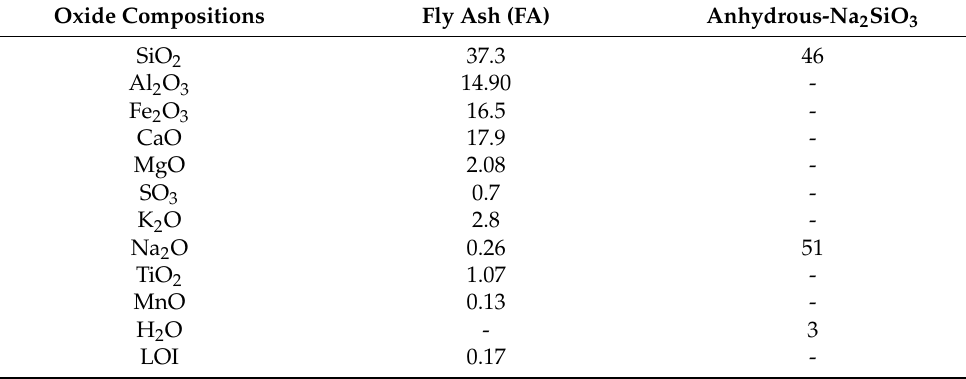
Table 1. Chemical composition of the binder materials (percentage by weight).